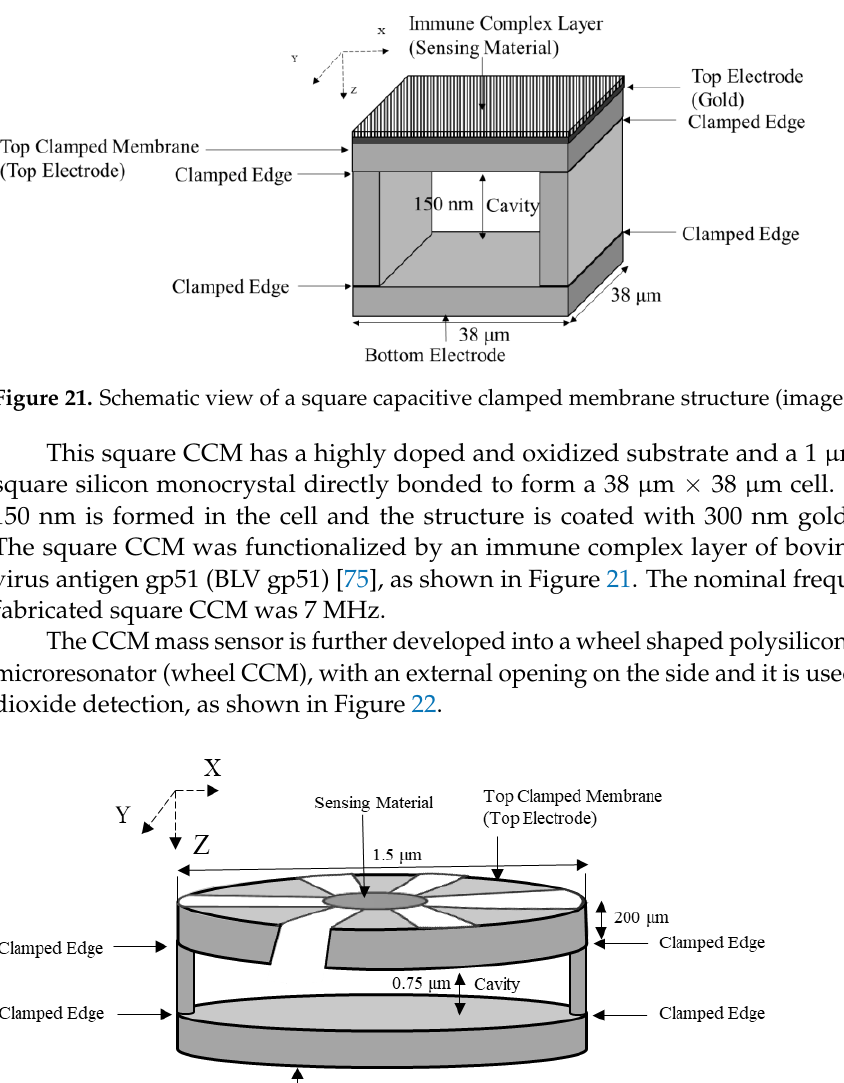
membrane thickness. Maximum deflection of about 4 femtometers (fm) is obtained in the middle of the structure, when